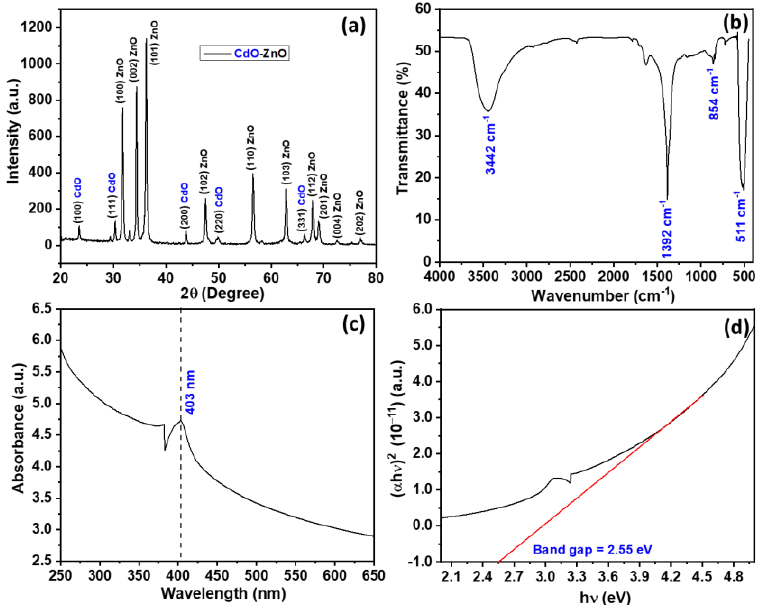
Figure 2. ( a ) XRD spectrum, ( b ) FTIR spectrum, ( c ) UV-Vis spectrum, and ( d ) Tauc’s plot for the determination of the optical band gaps for the as-synthesized CdO-ZnO nanocomposites (red line represents fitting the linear region to evaluate the band gap at the x-axis intercept and black line is expressing the variations of (αhν ) 2 vs. hν . Table 1. Crystalline parameters for the CdO-ZnO nanocomposites.